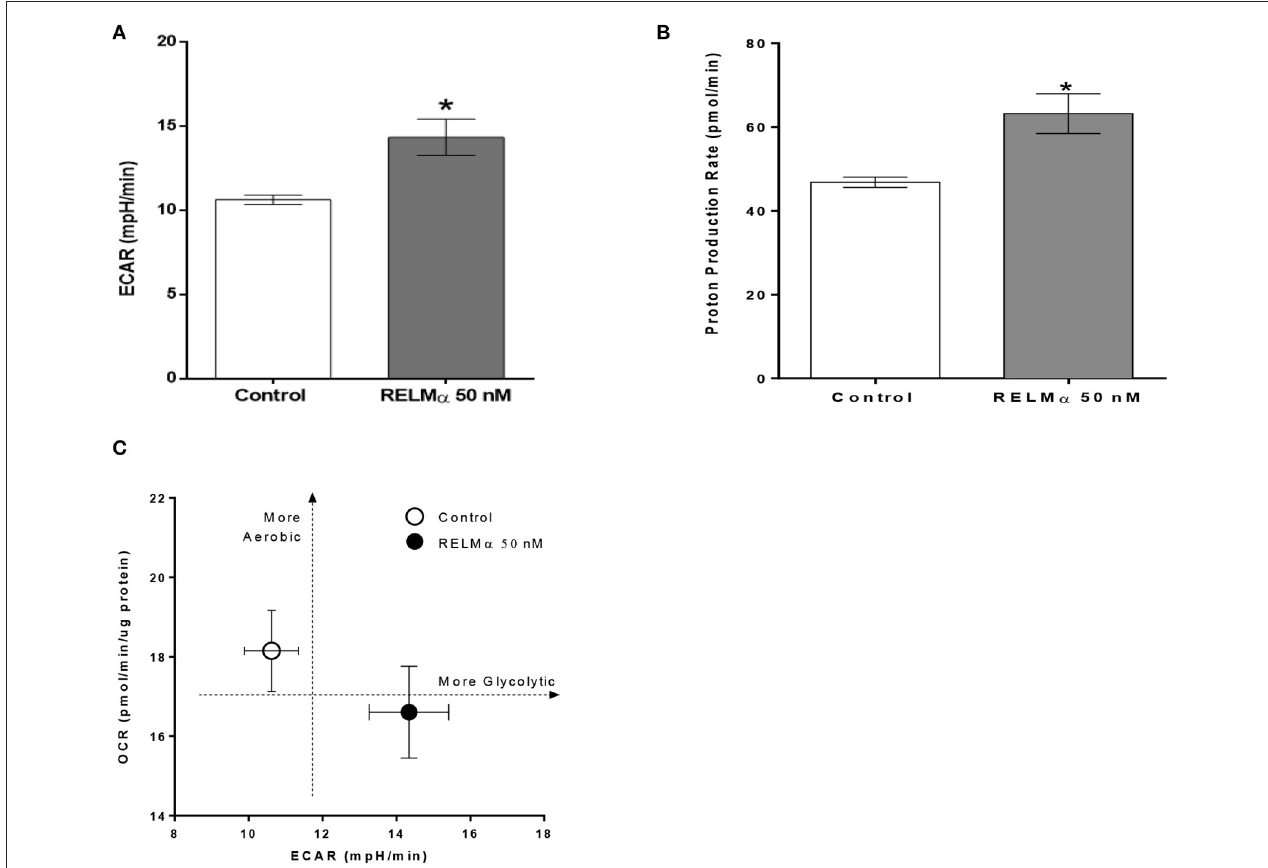
FIGURE 3 | Neonatal rat cardiomyoctyes (NRCMs) challenged with RELM α exhibit an increased ability to augment glycolysis. (A) Extracellular acidification rate (ECAR), (B) Proton production rate, and (C) Metabolic profile of the stimulatory effect of RELM α on oxygen consumption rate (OCR) and glycolysis in primary cultured cardiomyocytes. The OCR (y-axis) and ECAR (x-axis) were plotted against one another at the same time. n = 5 per group. * p < 0.05 vs. control group.